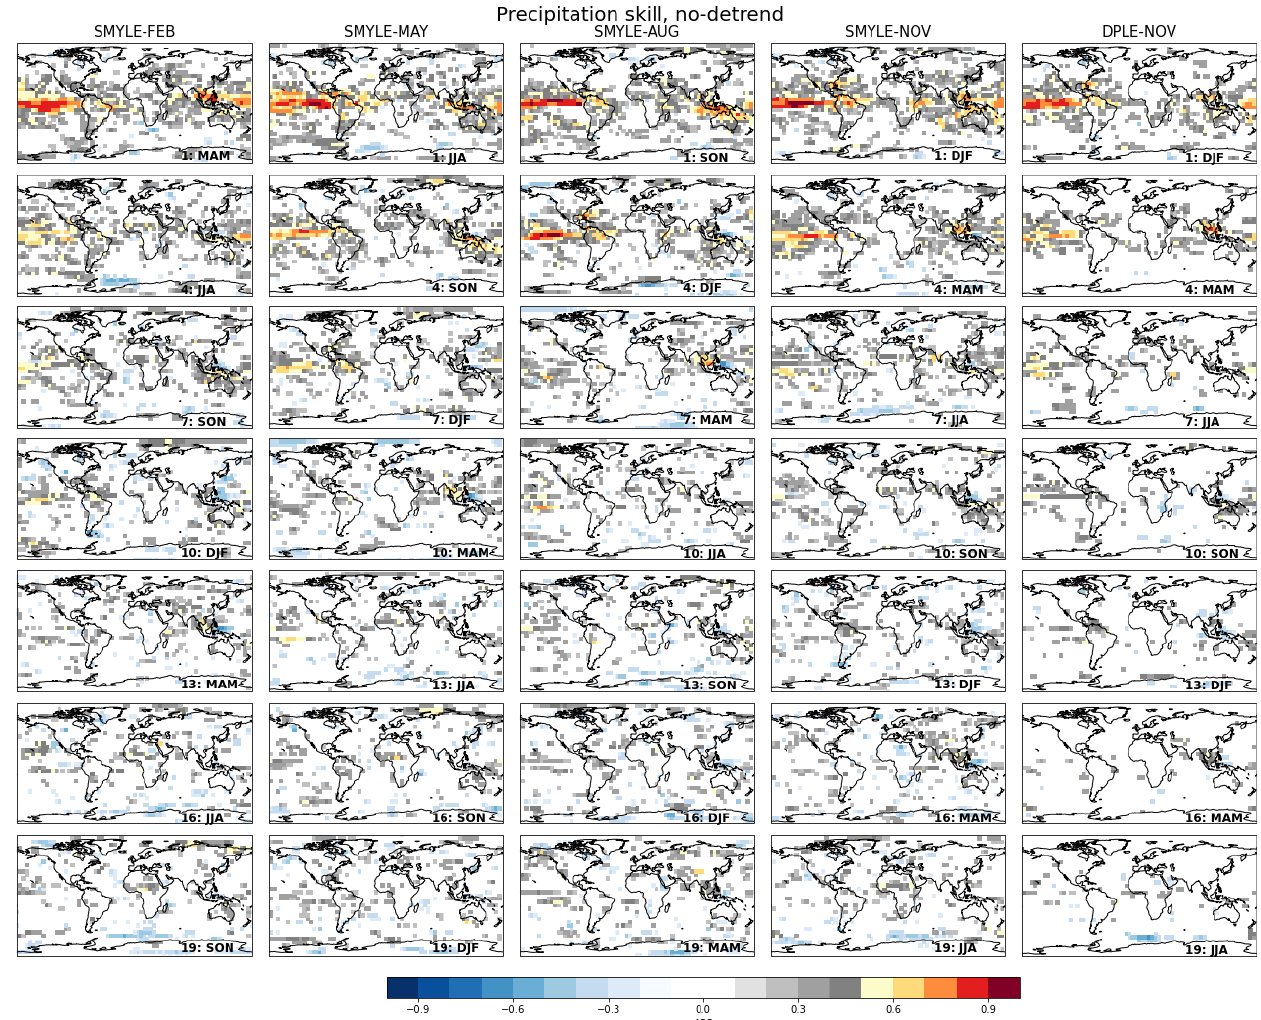
Figure B2. Equivalent to Fig. 2 (precipitation ACC) but without removing a linear